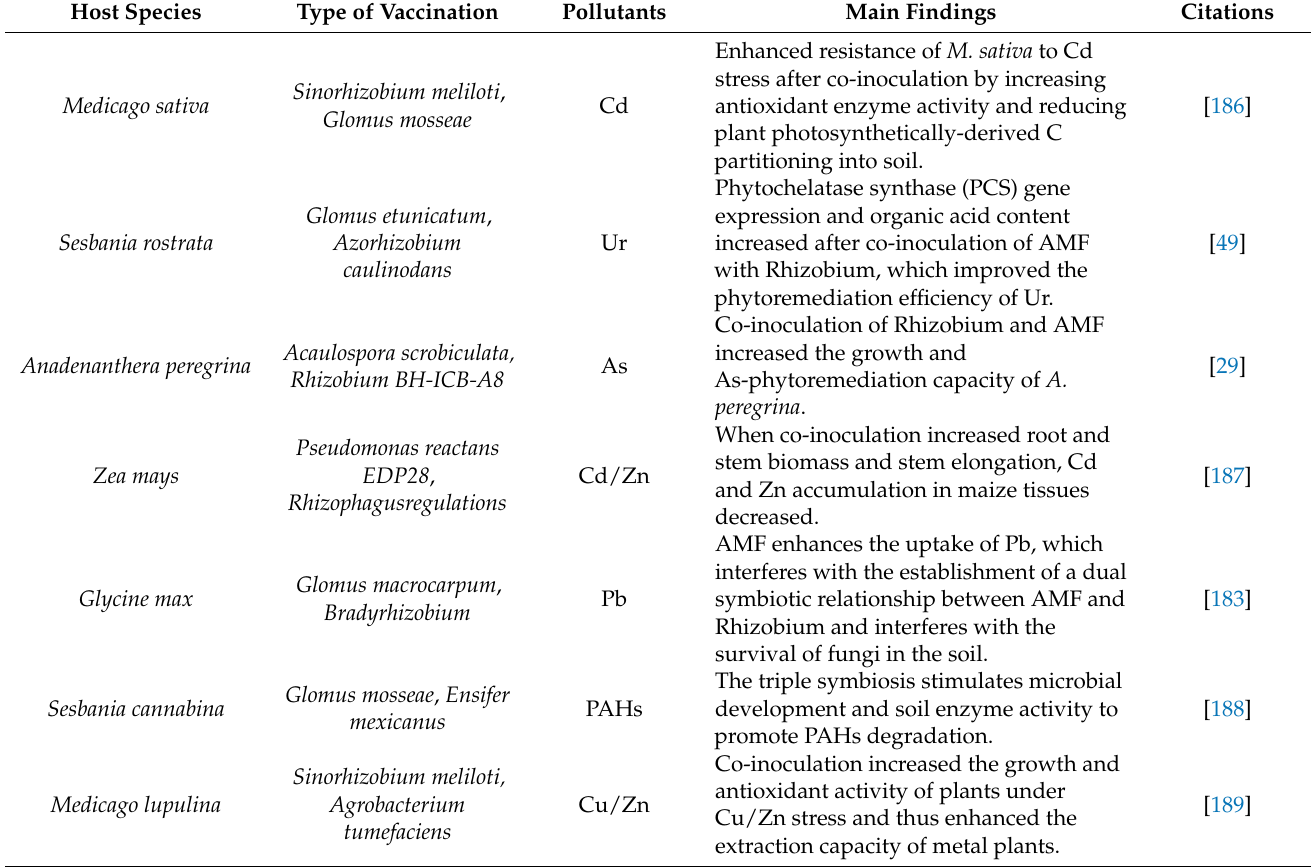
Table 3. Effects of Rhizobium and AMF on plants in tripartite symbiosis in recent